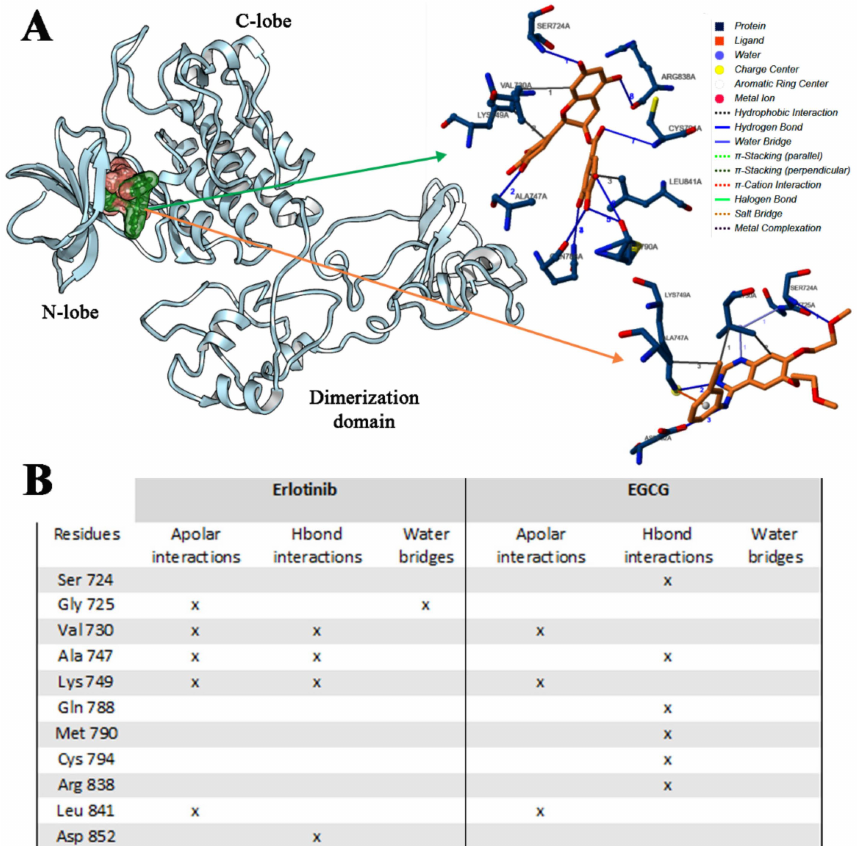
Figure 8. Binding a ffi nity of Erlotinib and EGCG in association with ELREA deletion EGFR domain ( A ), and interactions list of Erlotinib and EGCG with ELREA deletion EGFR ( B ). The 3D binding mode of Erlotinib (orange) and EGCG (green) has been